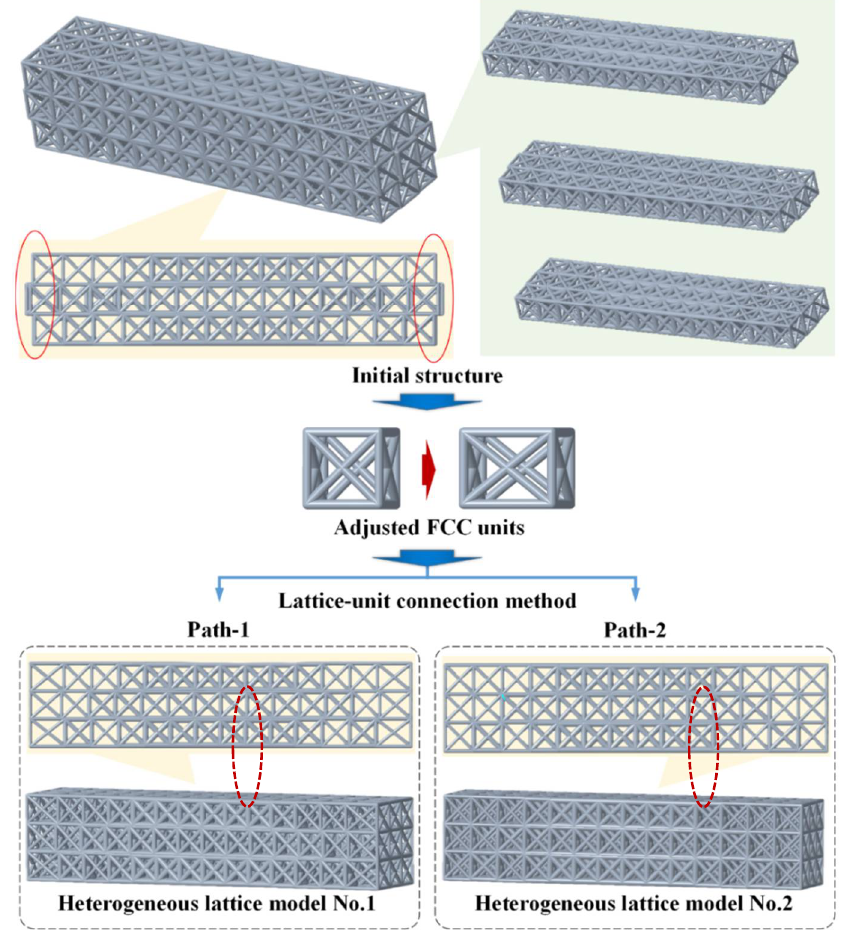
Figure 4. The design flow of the two structural optimization paths.